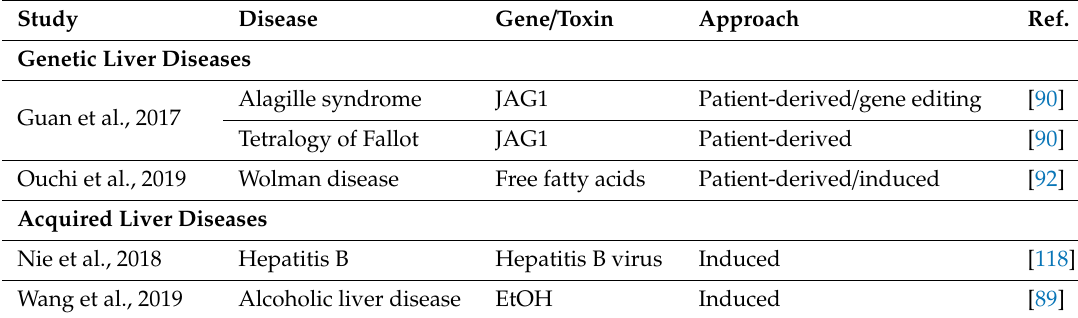
Table 3. Reported studies for disease modeling in hPSC-derived liver